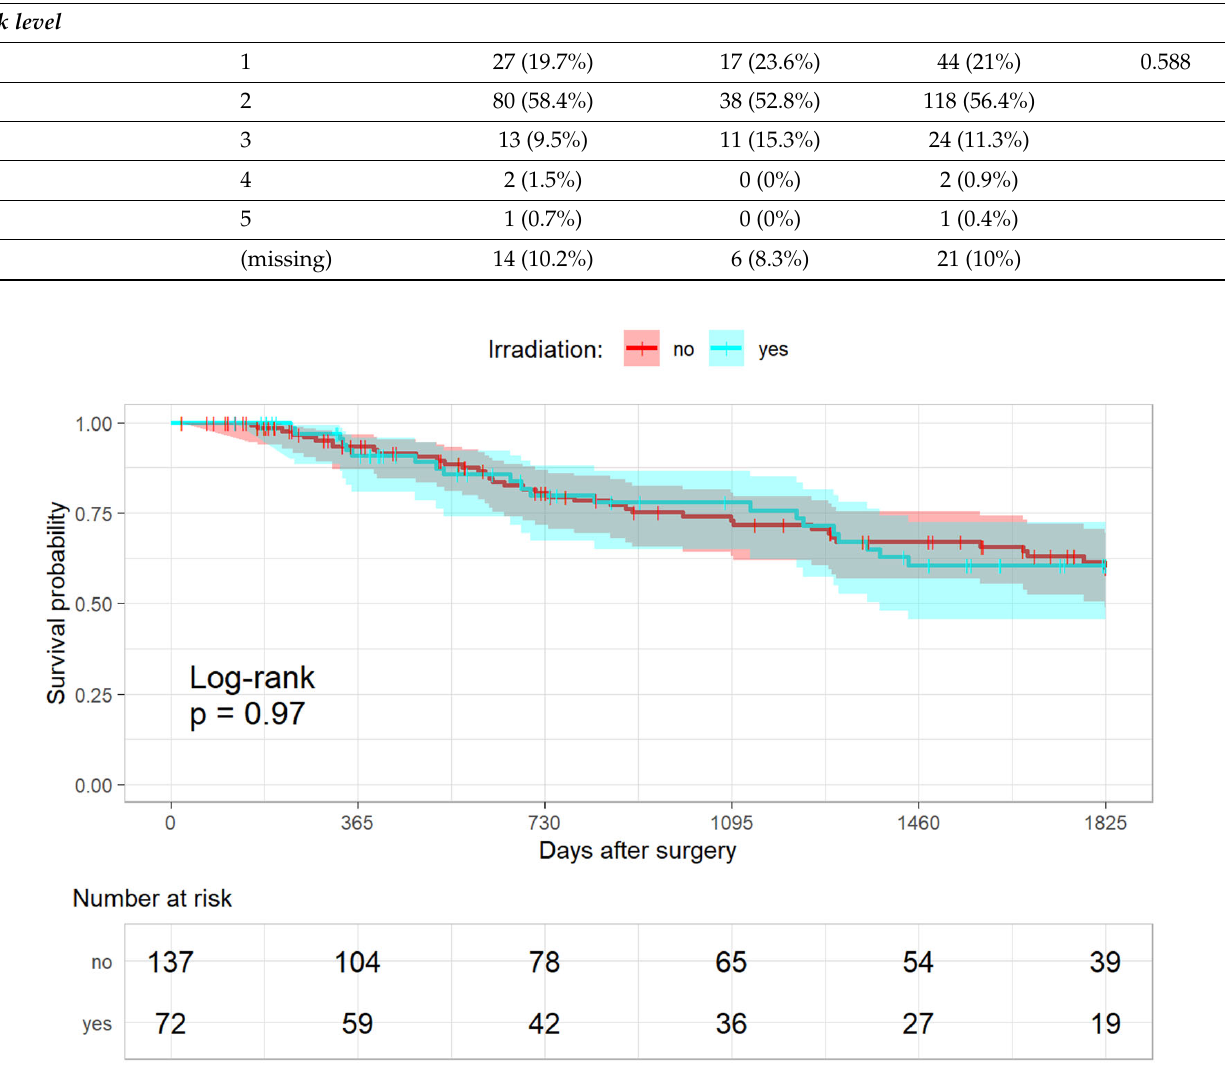
Figure 2. Kaplan-Meier analysis for overall survival.